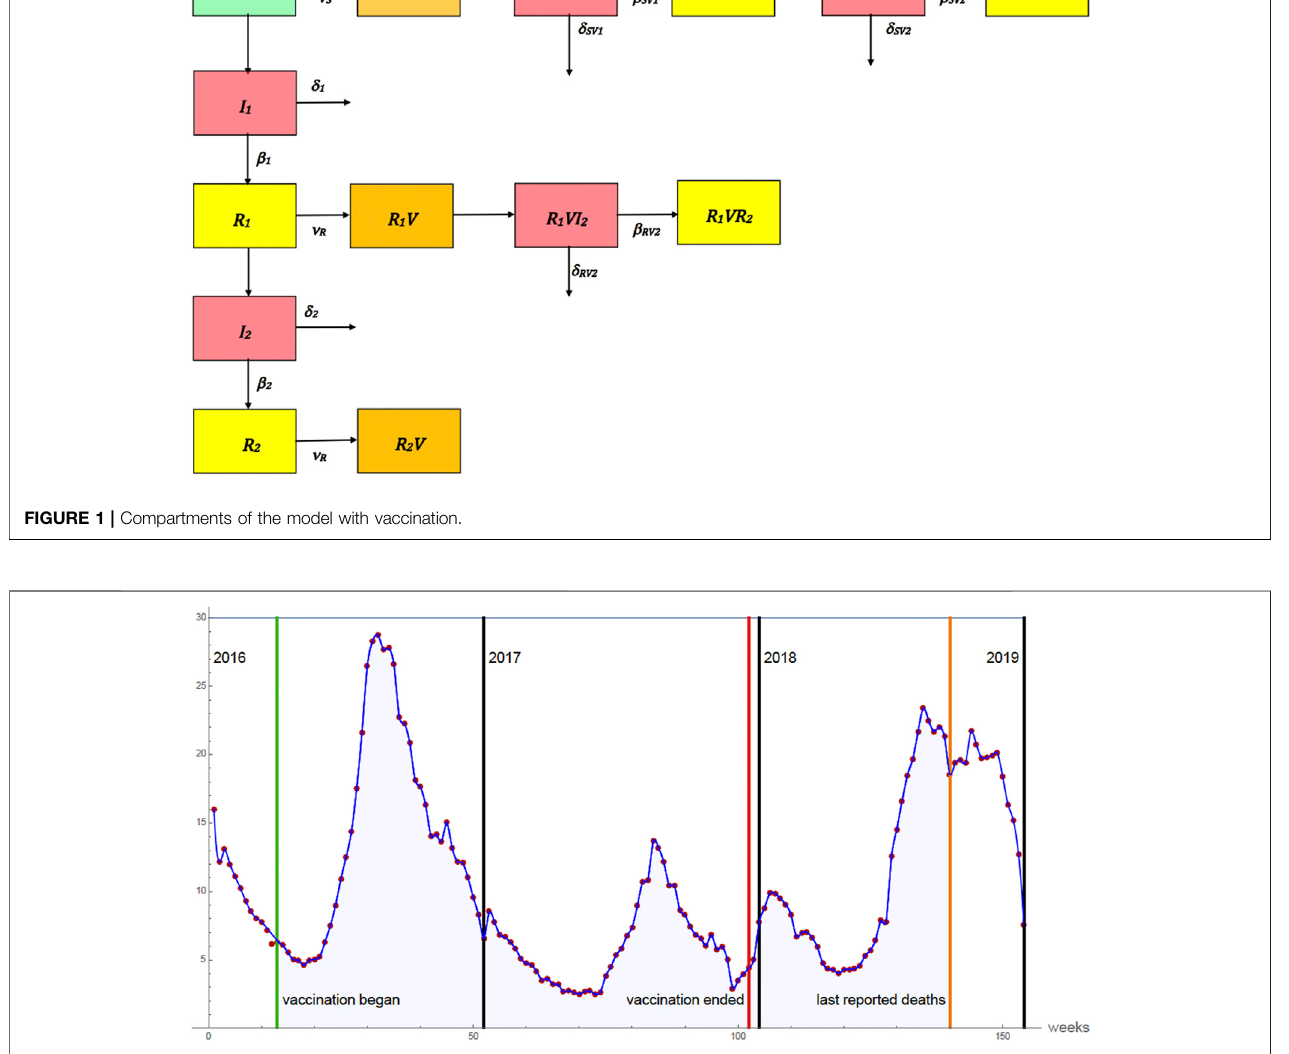
FIGURE 2 | The graph of Λ ( t ) for 2016, 2017, 2018.